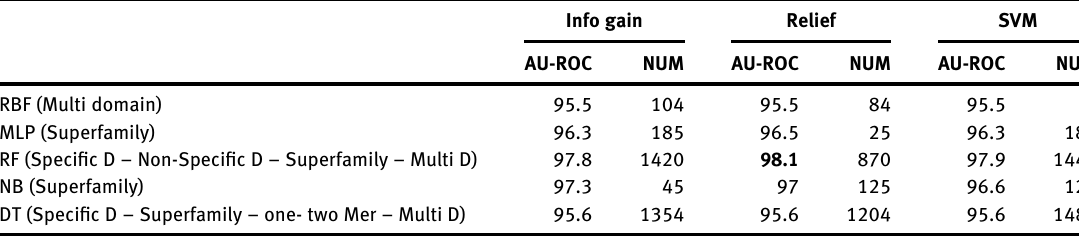
Table  : Comparison of the performance of algorithms after feature